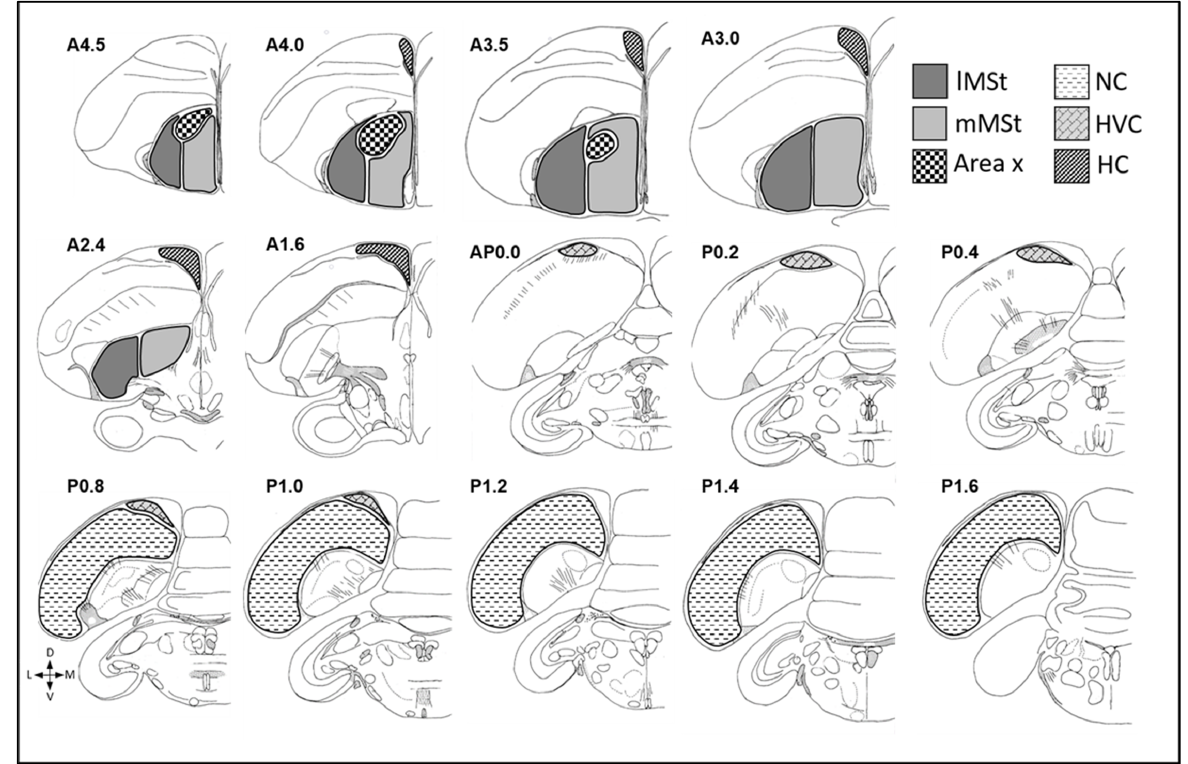
Figure 5. Mapping of new neuronal recruitment in several brain regions are shown. Illustrations of the mapped sections of medial striatum (MSt), nidopallium caudale (NC), hippocampus (HC), HVC and Area X are adapted with permission from Ref. [41]. Copyright 2021, Elsevier. Five sections of the lateral MSt (lMSt) and medial MSt (mMSt) (A4.5—A2.4), five sections of the NC (P0.8—P1.6), five sections of the HC (A4.0—A1.6), five sections of the HVC (AP0.0—P1.0) and three sections of Area X (A4.5—A3.5) are